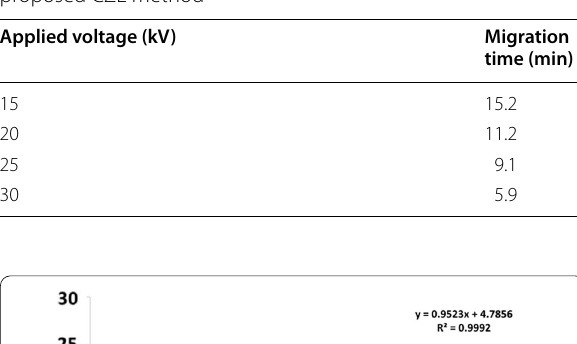
Table 8 Effect of the applied voltage on migration time for the analysis of TIG in intravenous infusion solution using the proposed CZE method